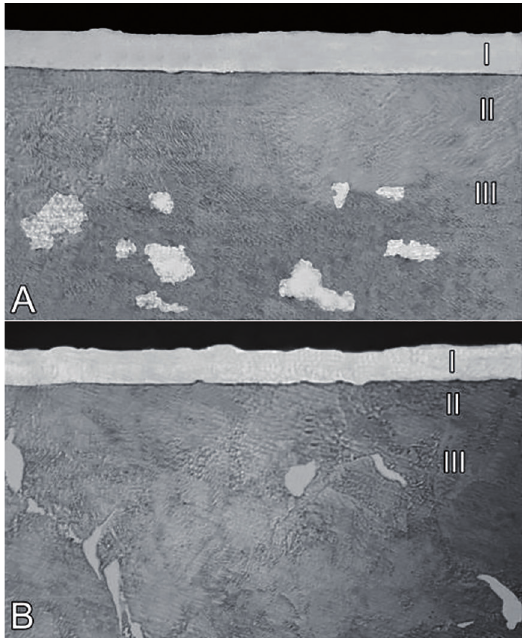
Figure 5: Cross-sectional morphology of the coatings (Optical Microscopy), 500 X. A - Chromizing, B - Chrome–boronizing– siliconizing (obtained using the mixture